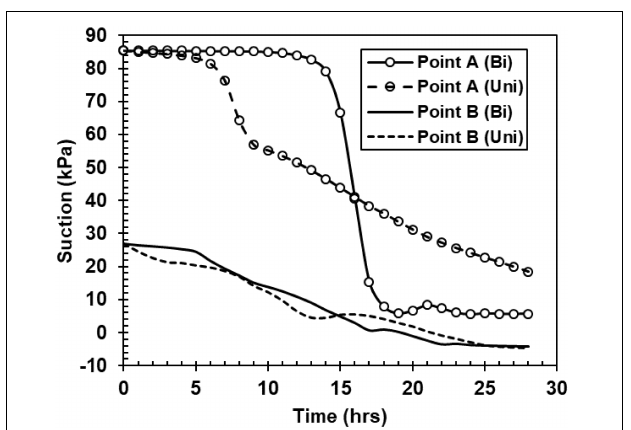
FIGURE 12 | Variations of suctions predicted using the bimodal and unimodal hydraulic properties at two points along the slip surface, where, the “Bi” and “Uni” represent the Bimodal and Unimodal functions,